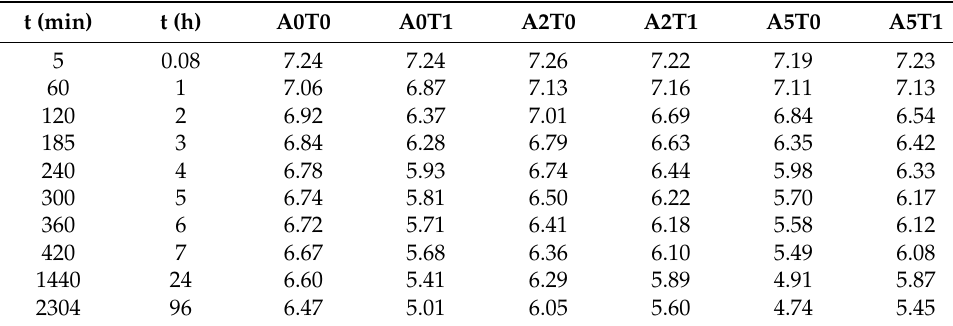
Table 6. Investigation of pH values of the samples.